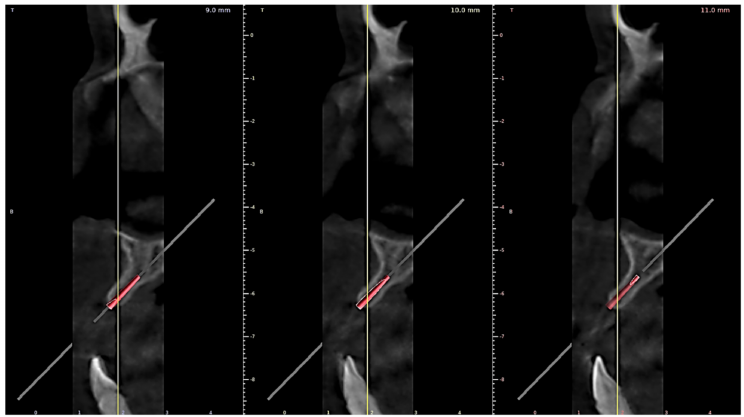
Figure 2. Insertion angle planning: 3D virtual model of the orthodontic mini-implant viewed in saggital plane sections of the CBCT investigation.